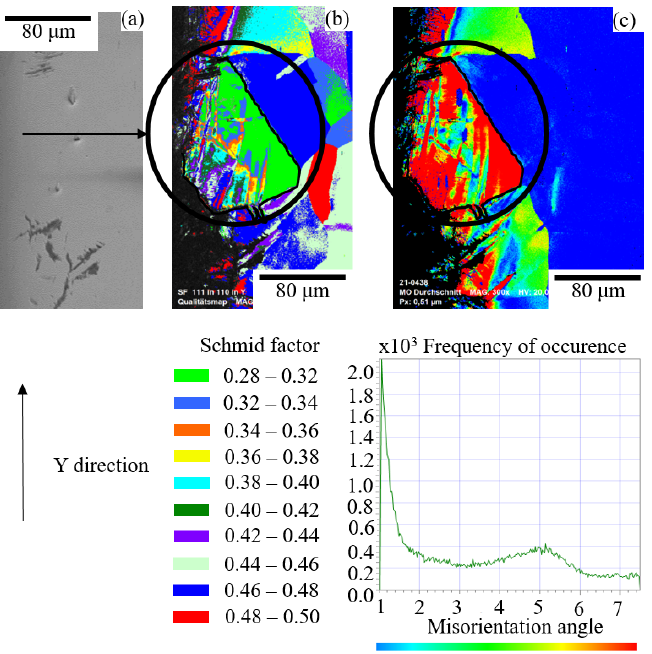
Figure 11. EBSD analysis of a specimen cut at room temperature: ( a ) SEM picture, ( b ) Schmid factor analysis of a non-transformed grain in Y direction for < 111 > in { 110 } and ( c ) GAM for 1–7.5 ◦ misorientaion angle.